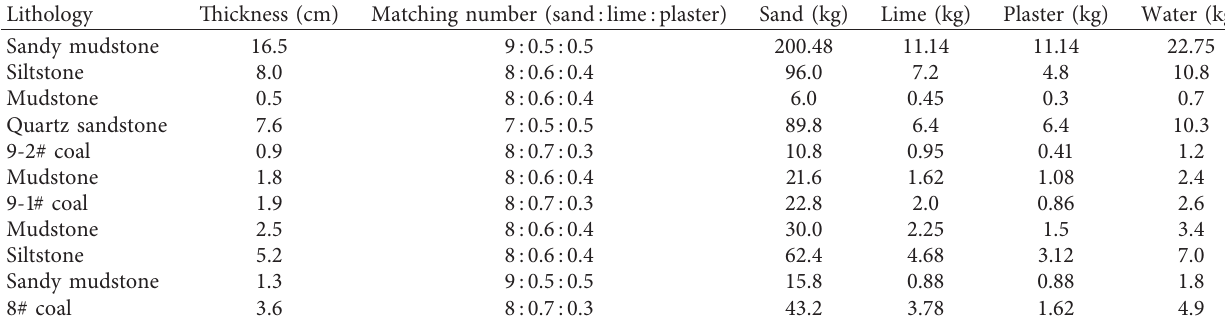
Table 5: Experimental model ratio.